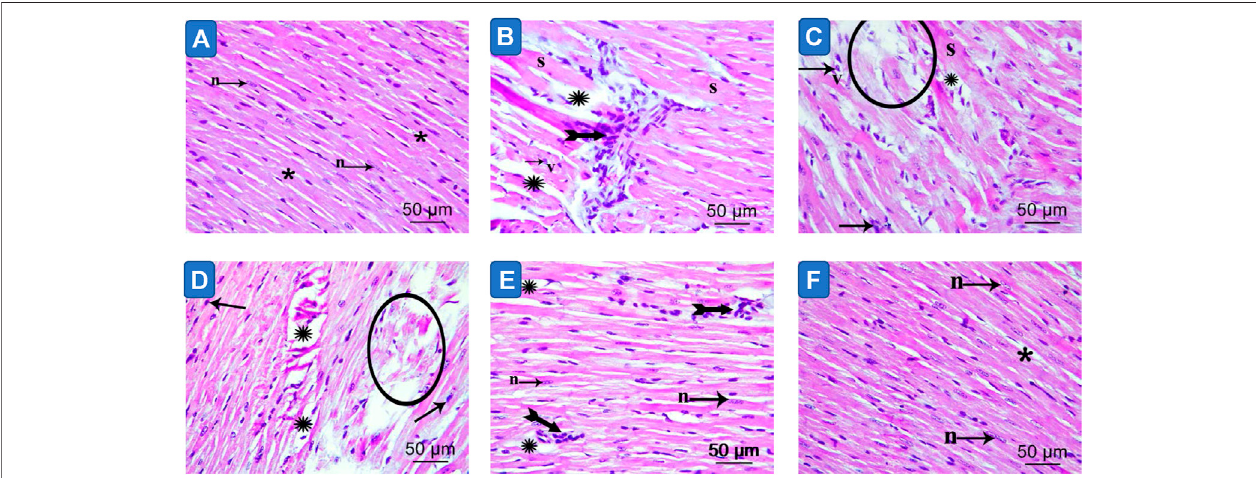
FIGURE 6 | Photomicrograph of sections in the ventricular wall of control (image A) , Metabolic syndrome (images B, C) , plain formula (image D) , quercetin suspension (image E) and quercetin nano-formula (image F) groups. Bi fi d arrows represent; mononuclear cellular in fi ltration was evident in between the cardiac